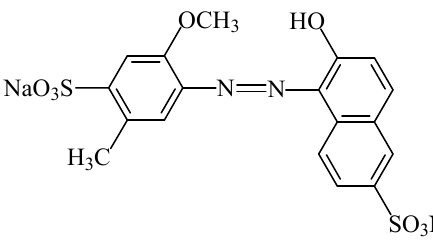
Figure 22. Structural formula of allura red AC (E129).